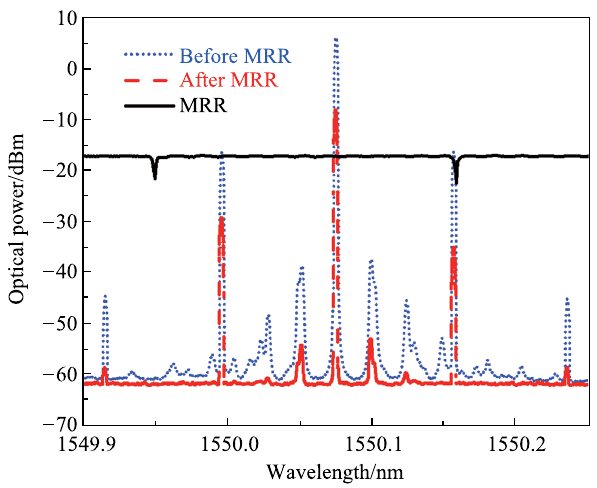
Fig. 4 Measured optical spectra. The black solid curve shows the transmission of the MRR. The blue dotted curve and the red dashed curve show the phase modulated signals before and after the MRR, respectively